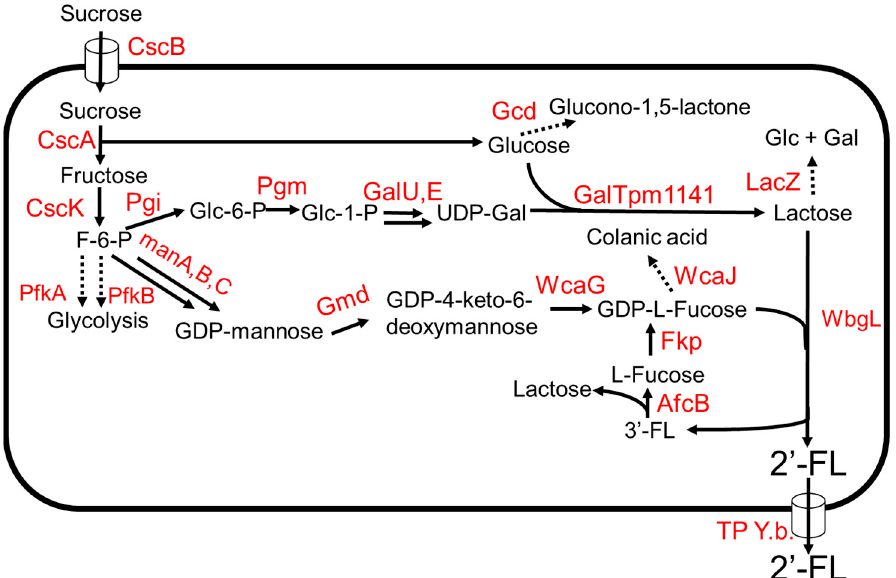
Figure 3. The 2 (cid:48) FL production from sucrose. Dotted arrows indicate competing pathways. Abbrevia- Figure 3 . The 2 ′ FL production from sucrose. Dotted arrows indicate competing pathways. Abbrevi- tions: ManA, mannose-6-phosphate isomerase; ManB, phosphomannomutase; ManC, α ations: ManA, mannose-6-phosphate isomerase; ManB, phosphomannomutase; ManC, α -D- mannose-1-phosphate guanyltransferase; Gmd, GDP-D-mannose-4,6-dehyratase; WcaG, GDP-L-